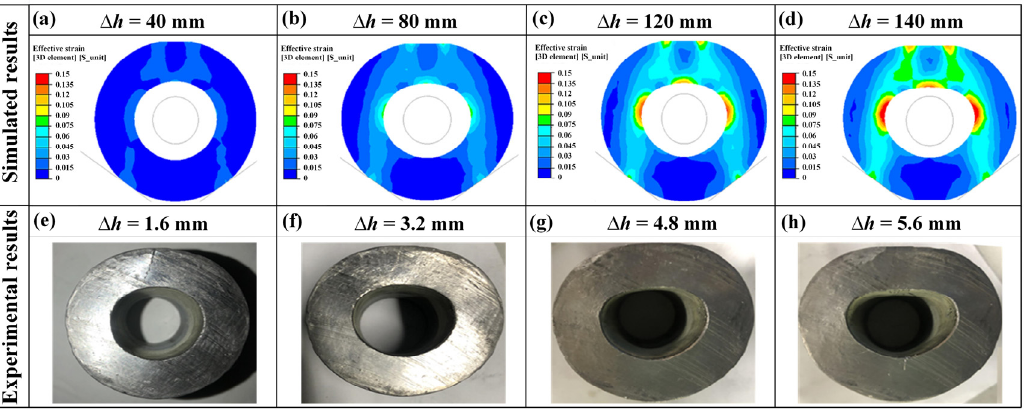
Figure 9. Deformation under different pressing reductions: ( a – d ) simulated results; ( e – h ) experi- mental results with a shrinkage ratio of 25:1.